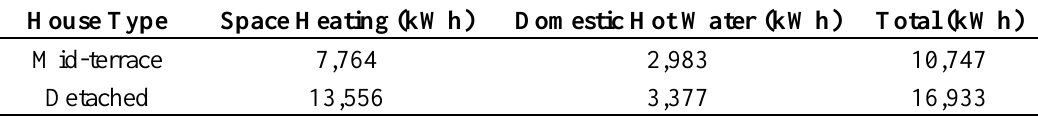
Table 1. Simulated annual energy demand for two typical UK house